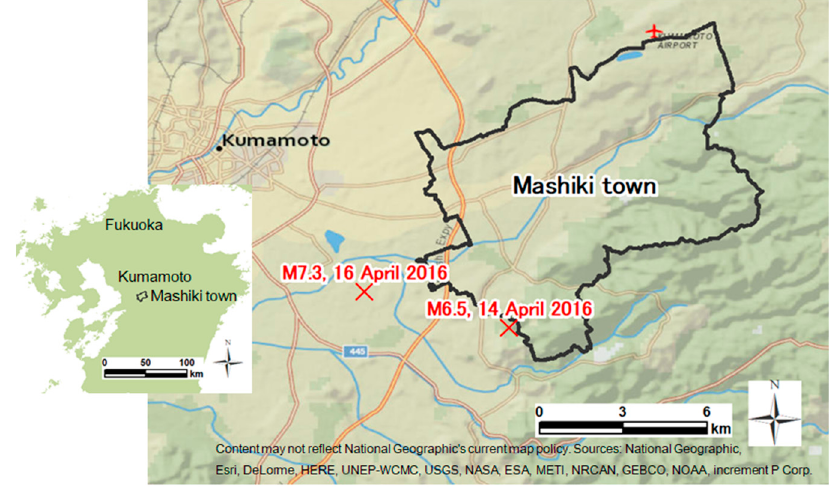
Figure 1. Location of epicenters of the 2016 Kumamoto earthquake (fore- and main-shocks) and Mashiki town.